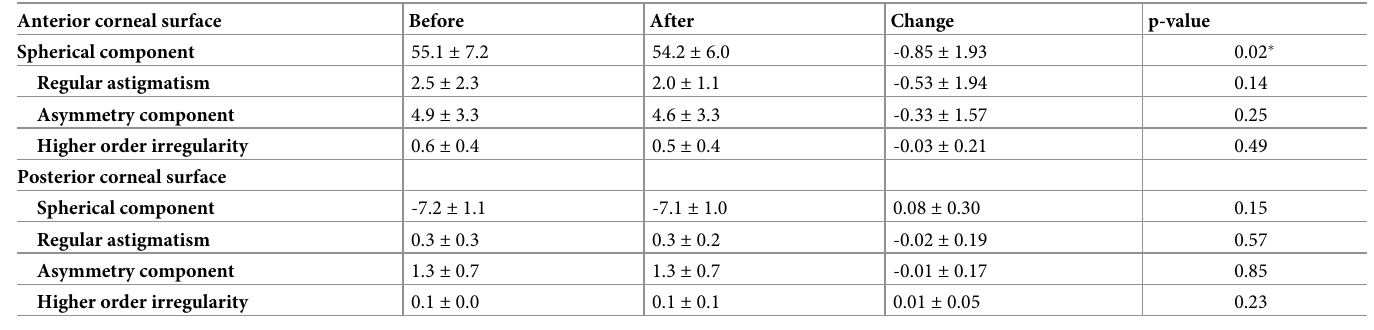
Fourier harmonic analysis of the anterior and posterior corneal surfaces Changes in corneal parameters evaluated with Fourier harmonic analysis for the anterior and posterior corneal surfaces are summarized in Table 3. The spherical component of the anterior corneal surface significantly decreased after the use of the RGP lens (p = 0.02). There was no Table 3. Changes in corneal anterior and posterior surface indices evaluated with Fourier harmonic analysis before and after the use of a rigid gas-permeable con- tact lens. Anterior corneal surface Before After Change p-value Spherical